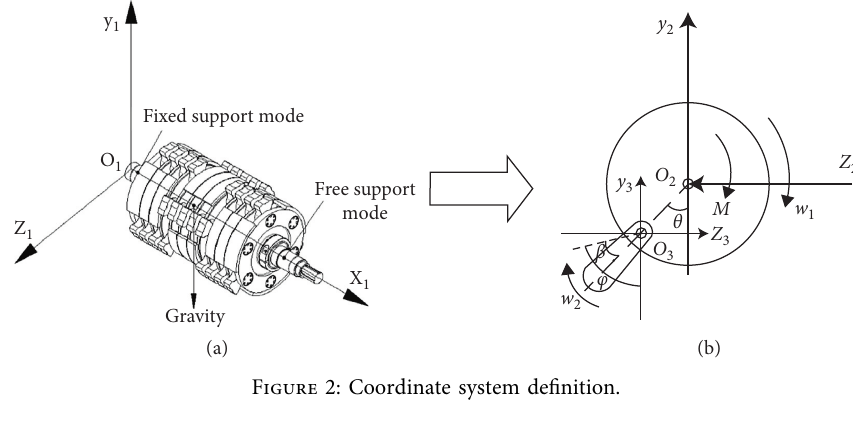
Figure 2: Coordinate system definition.